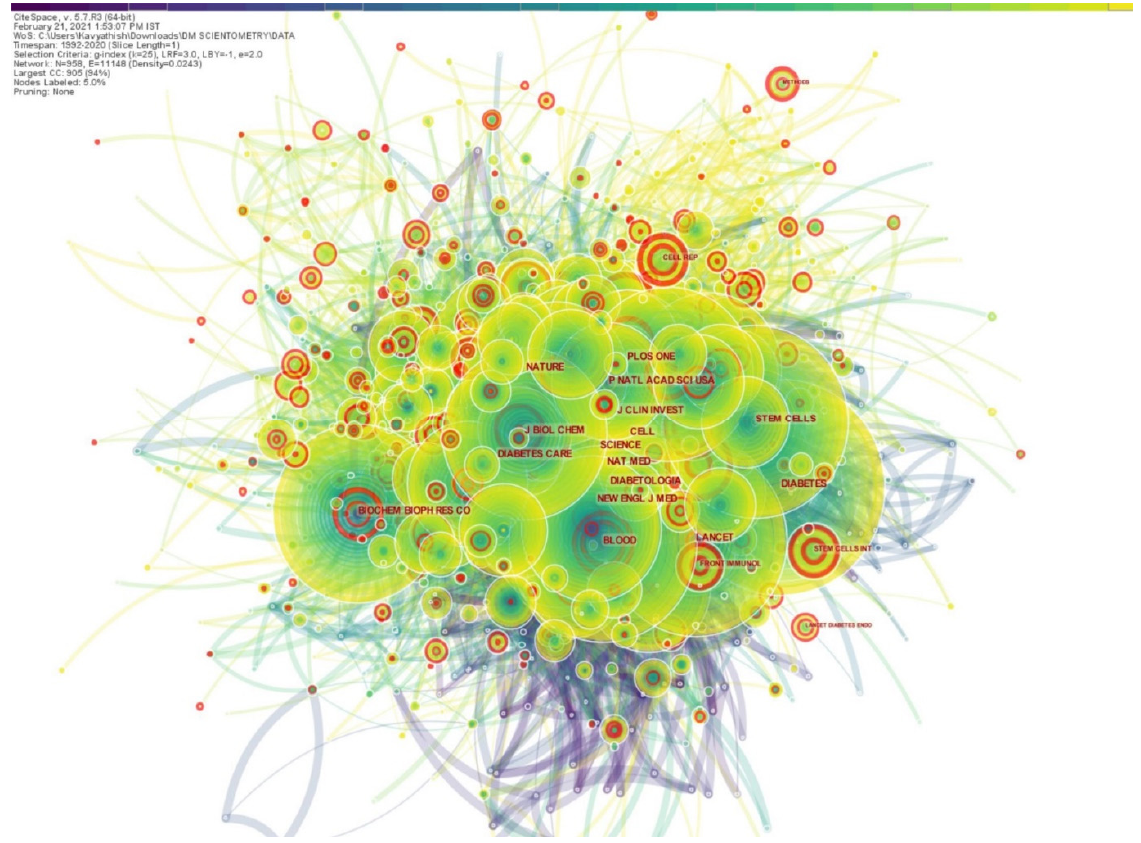
Figure 3. Journal citation network of stem cell therapy research for diabetes mellitus.